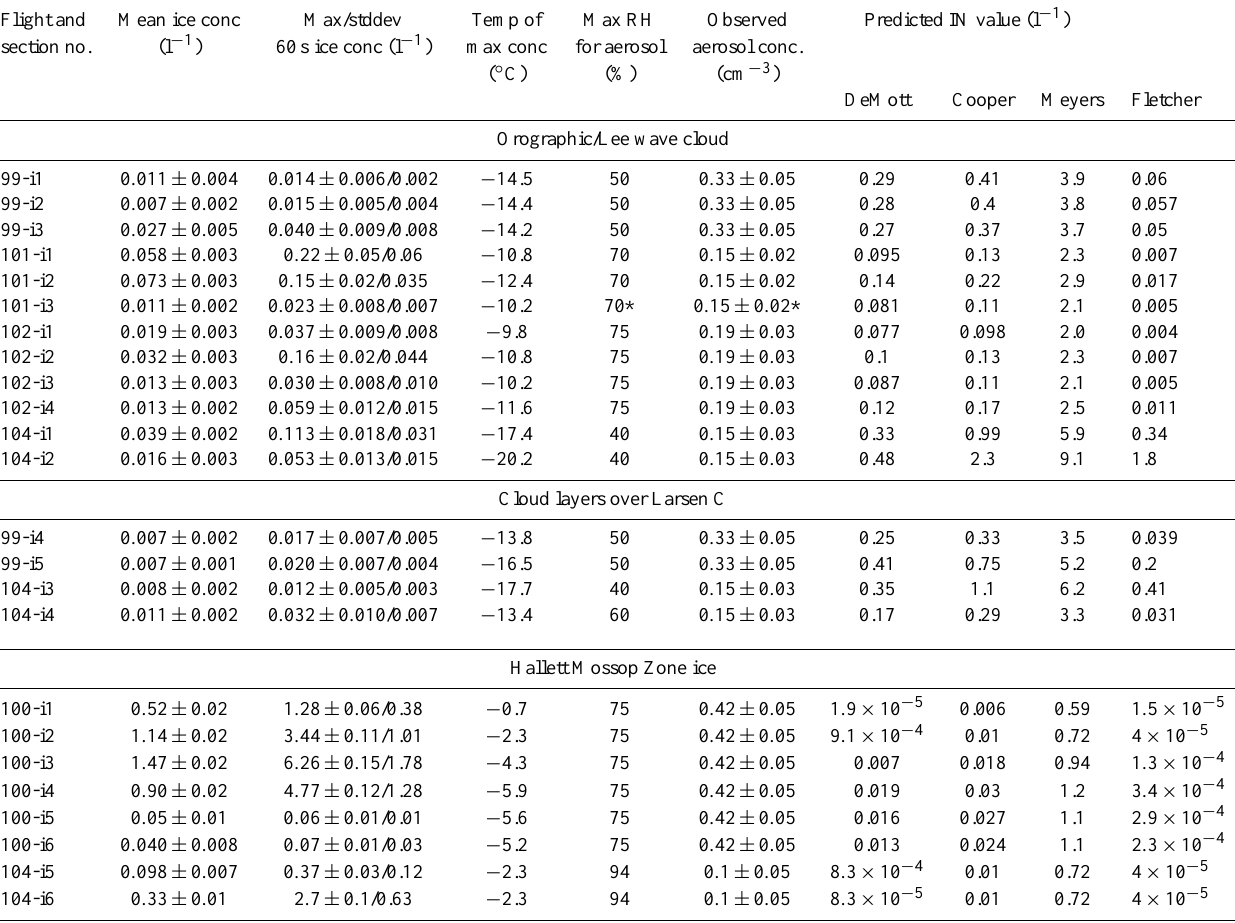
Table 3. Predicted IN values from various parameterizations (see text) at the temperature of the observed maximum ice concentrations for the periods identified in Table 1. Also shown are aerosol concentrations observed near to these sections along with the maximum relative humidity value at which aerosol averages were taken. Flight and Mean ice conc Max/stddev Temp of Max RH Observed Predicted IN value (l − 1 ) section